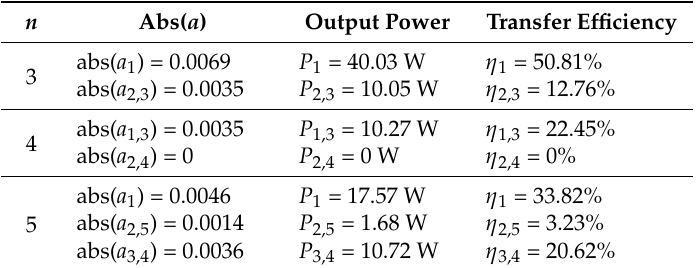
Table 2. Steady state solutions for multi-receiver system.